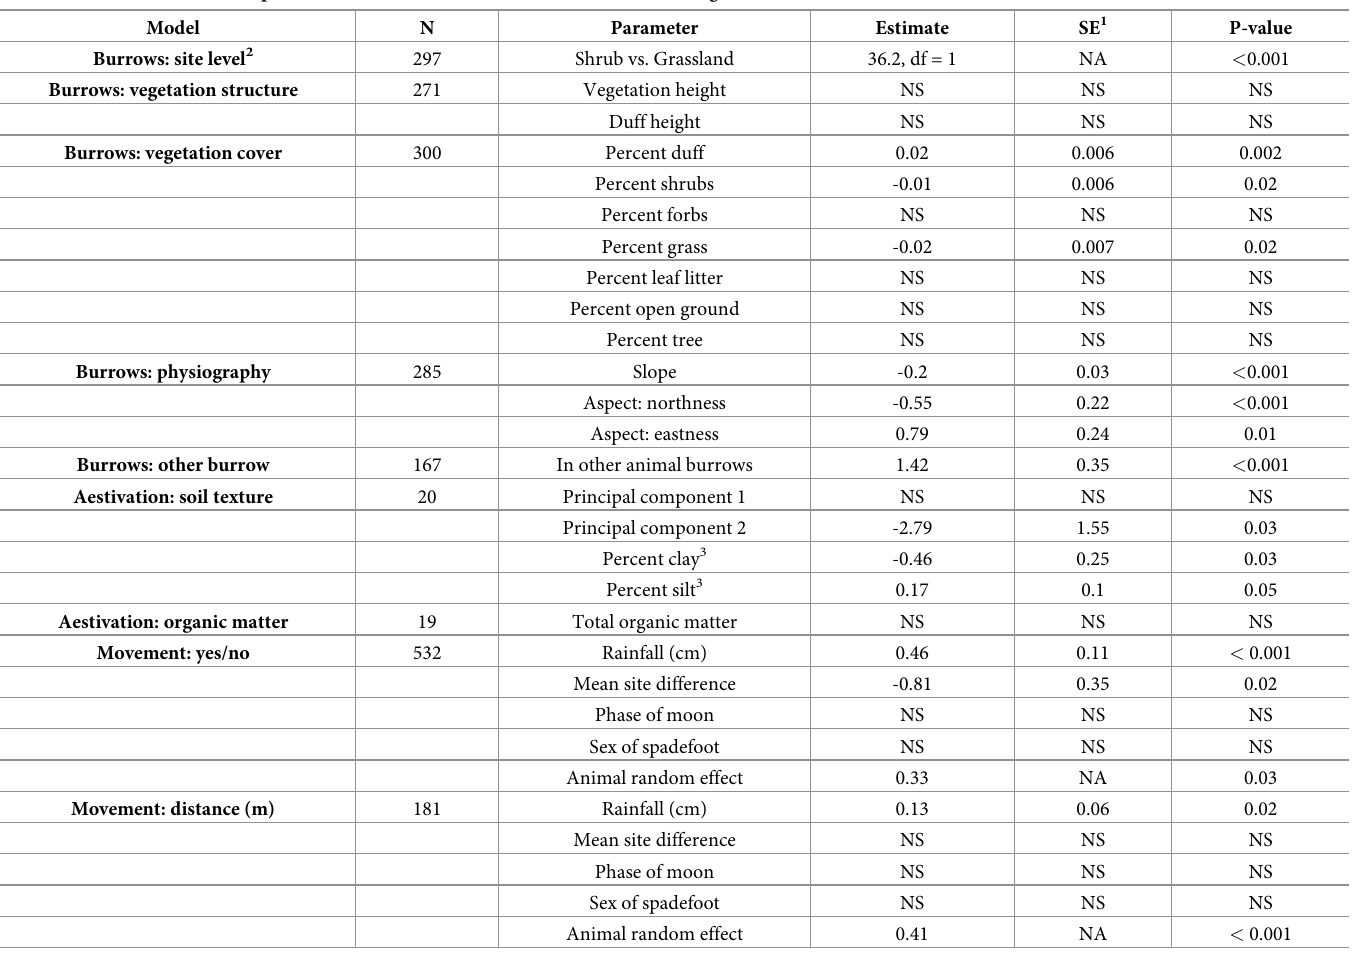
Table 3. Model untransformed parameter estimates, standard errors, and statistical